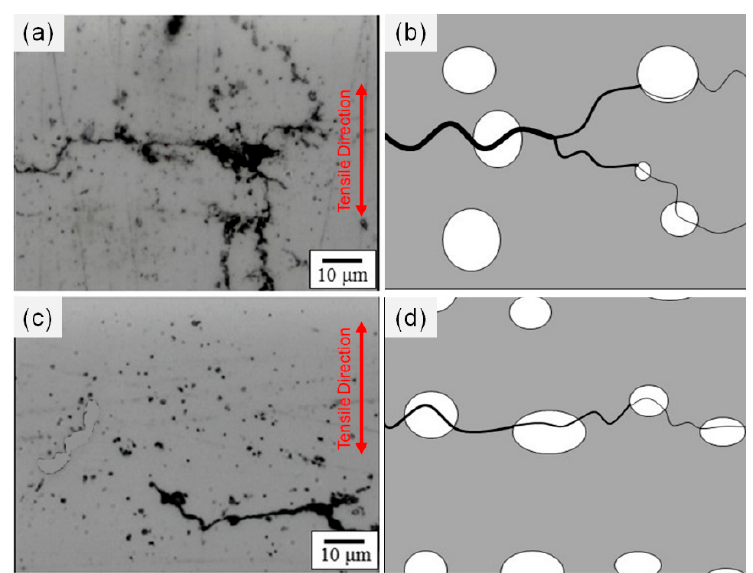
Figure 11. Fracture mechanism of XK105-H. ( a ) LM secondary surface morphology on ED plane, ( b ) fracture mechanism illustration for ED plane, ( c ) LM secondary surface morphology on TD plane, and ( d ) fracture mechanism illustration for TD plane.